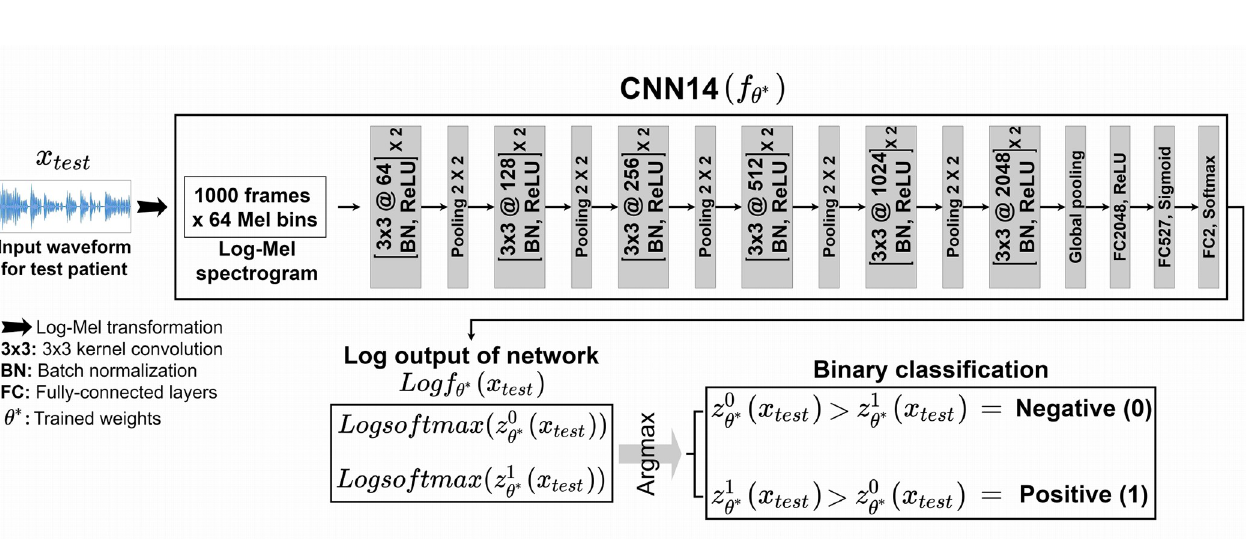
Fig 4. Configuration of CNN14. CNN14 is a representative network developed for audio-based classification, which converts input waveform into a log-Mel spectrogram (i.e., converts one-dimensional information into two-dimensional image type information) and makes the CNN appended to the spectrogram. The CNN is composed of convolution, batch normalization, and FC layers. In this study, the output size of the last layer was resized as two for binary classification, and transfer learning was adopted.